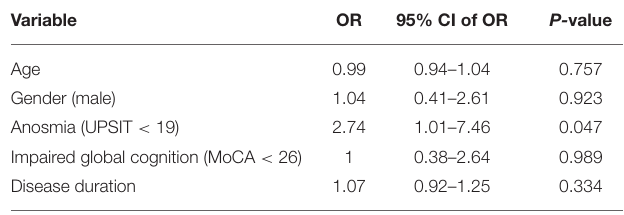
TABLE 3 | Logistic regression results for depression (BDI-II ≥ 14).